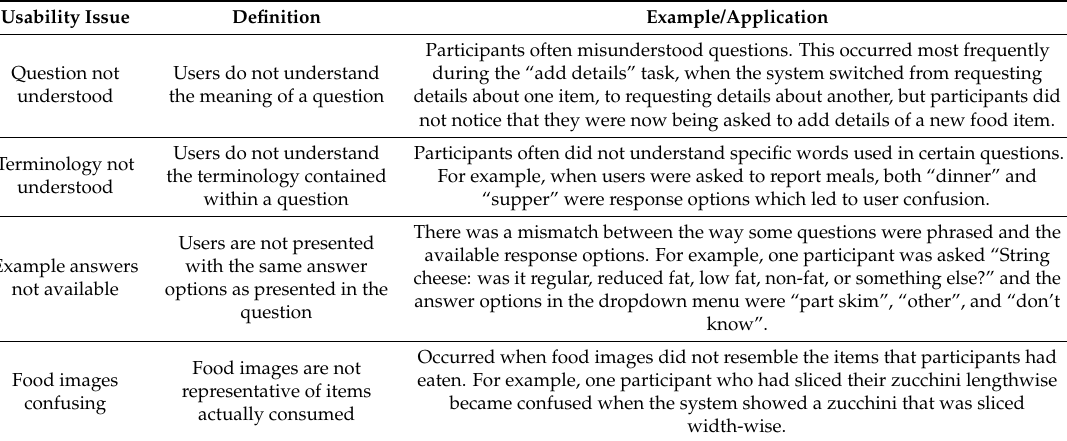
Table 7. Descriptions and examples of usability issues related to